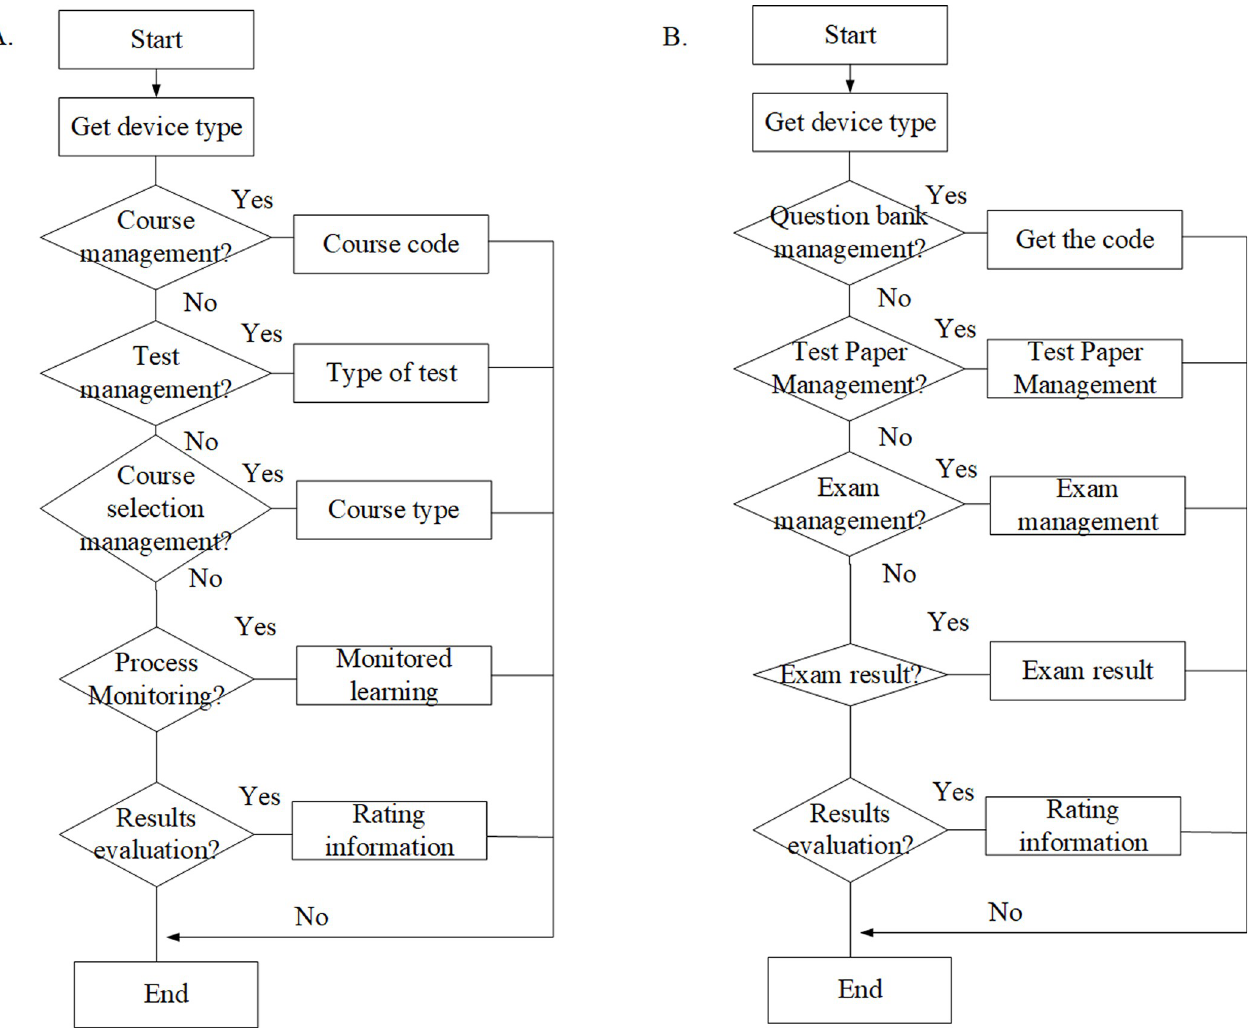
Fig 11. The flow chart of the learning management and exam management module. Note: Figure a shows the flow chart of learning management module, and Figure b shows the flow chart of exam management module.